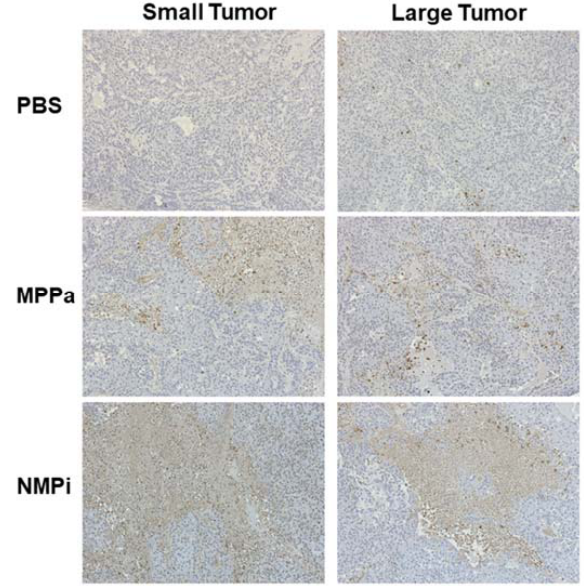
Figure 10. Terminal deoxyribonucleotidyl transferse ‐ mediated dUTP nick ‐ end labelling (TUNEL) staining of tumor tissues in A549 tumor ‐ bearing mice (small ‐ tumor group <50 mm 3 and large ‐ tumor group >50 mm 3 ) on Day 15, after double intravenous injection (on Days 0 and 2, repeated two times PDT) of PBS, MPPa (2 mg/kg), and NMPi (2 mg/kg) with 200 J/cm 2 light irradiation on one day after each injection (on Days 1 and 3, repeated two times PDT). This result also had a good agreement with therapeutic effects observed in the H&E staining images in Figure 8. The magnification is 40 ×